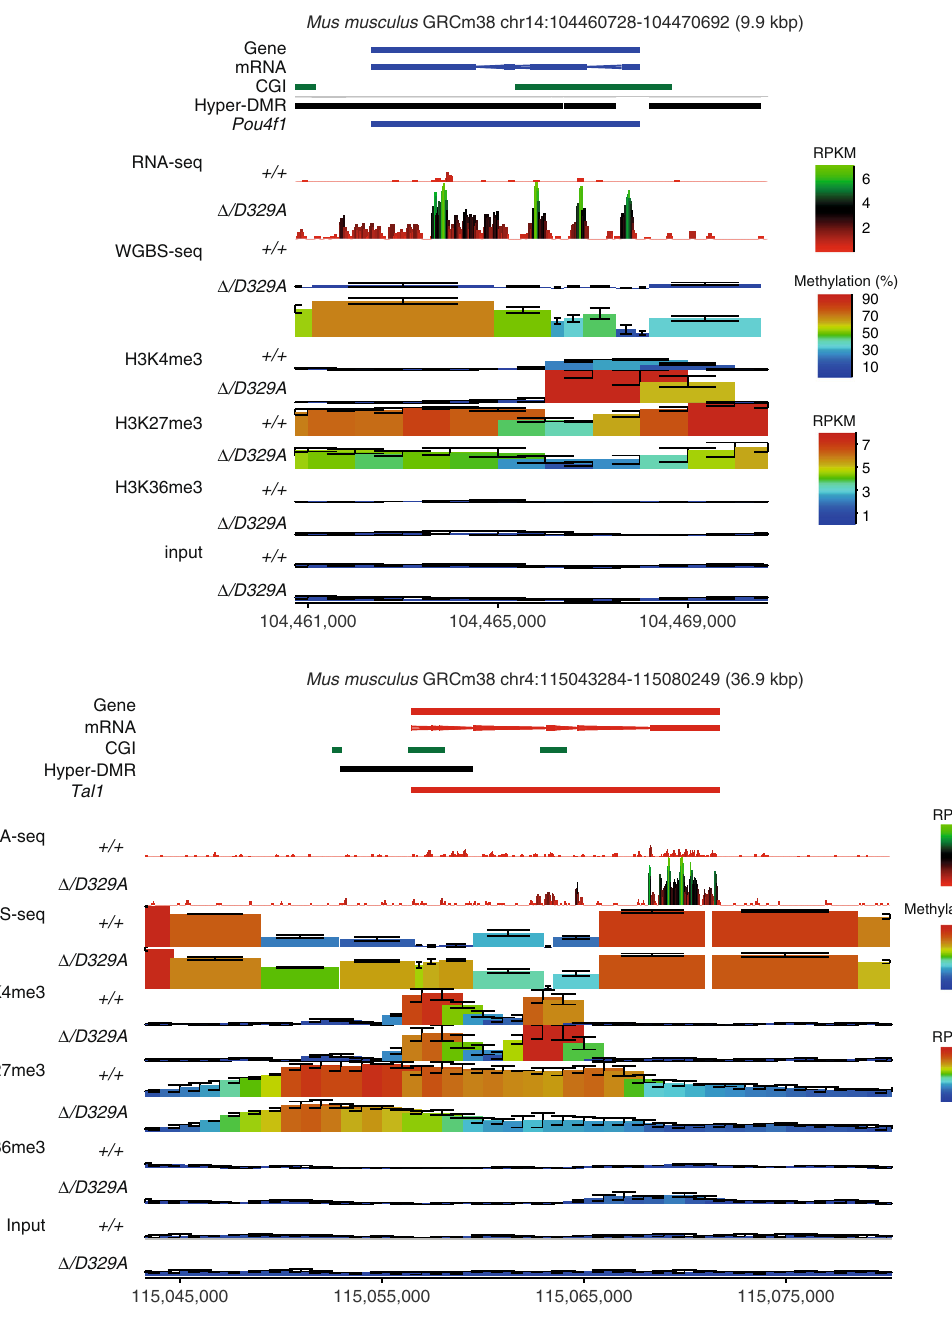
Fig. 7 Genomic landscape of de-repressed genes in Dnmt3a Δ /D329A hypothalamus. a , b Representative genome browser views of gene expression, DNA methylation, and distribution of H3K4me3, H3K27me3, and H3K36me3 marks (determined by ChIP-seq) in adult (14-week) male hypothalamus of Dnmt3a + / + and Dnmt3a Δ /D329A genotypes. H3K4me3 and H3K36me3 are enriched over actively transcribed CGI promoters and gene bodies, respectively. H3K27me3 shows a broad enrichment over transcriptionally silent genes and loss of enrichment upon methylation gain. Genes a Pou4f1 and b Tal1 are up- regulated and hypermethylated in Dnmt3a Δ /D329A . CGI: CpG island, DMR: hypermethylated region. Each colour-coded block represents: a 50 bp window with 10 bp step size in the gene expression dataset; a 100-CpG window in the methylation dataset; and 2 kb window with 1 kb step size in the histone enrichment datasets. For gene and mRNA tracks, the colour indicates direction, where red is a forward strand and blue is a reverse strand. Error bars indicate standard deviation. n ( + / + ) = 5, n( Δ /D392A ) = 4 for RNA-seq datasets; n = 3 for each genotype in WGBS-seq and ChIP-seq